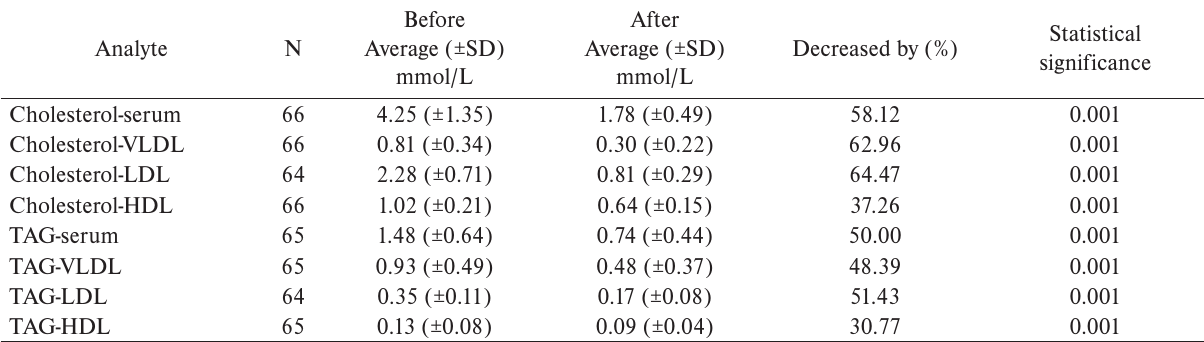
Table 1. Levels of cholesterol and TAG in serum and lipoprotein fractions before and after RH treatment. Before Analyte N